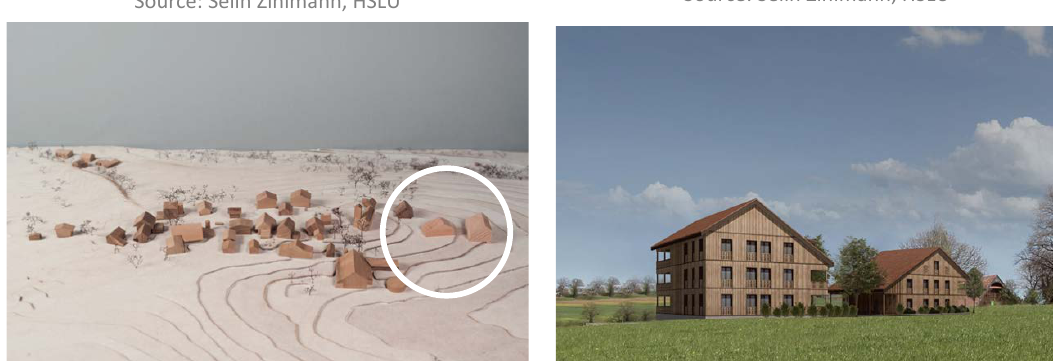
Figure 12. Development proposal for an old barn Figure 13. Development proposal for an old barn